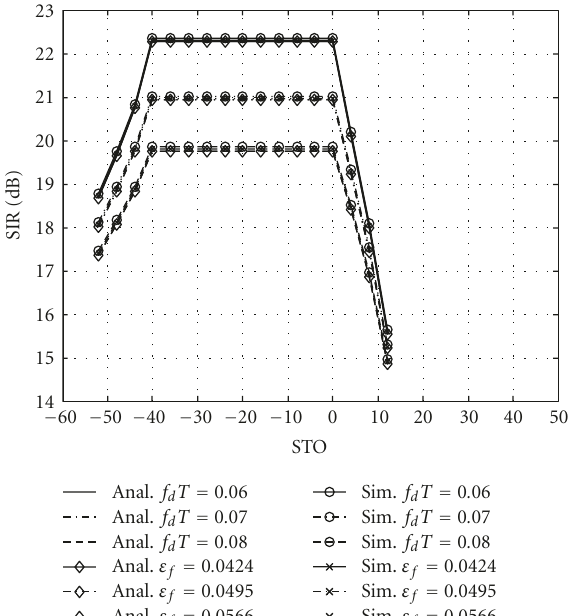
Figure 3: SIR plotted against STO, under the influences of the CFO and NDF.